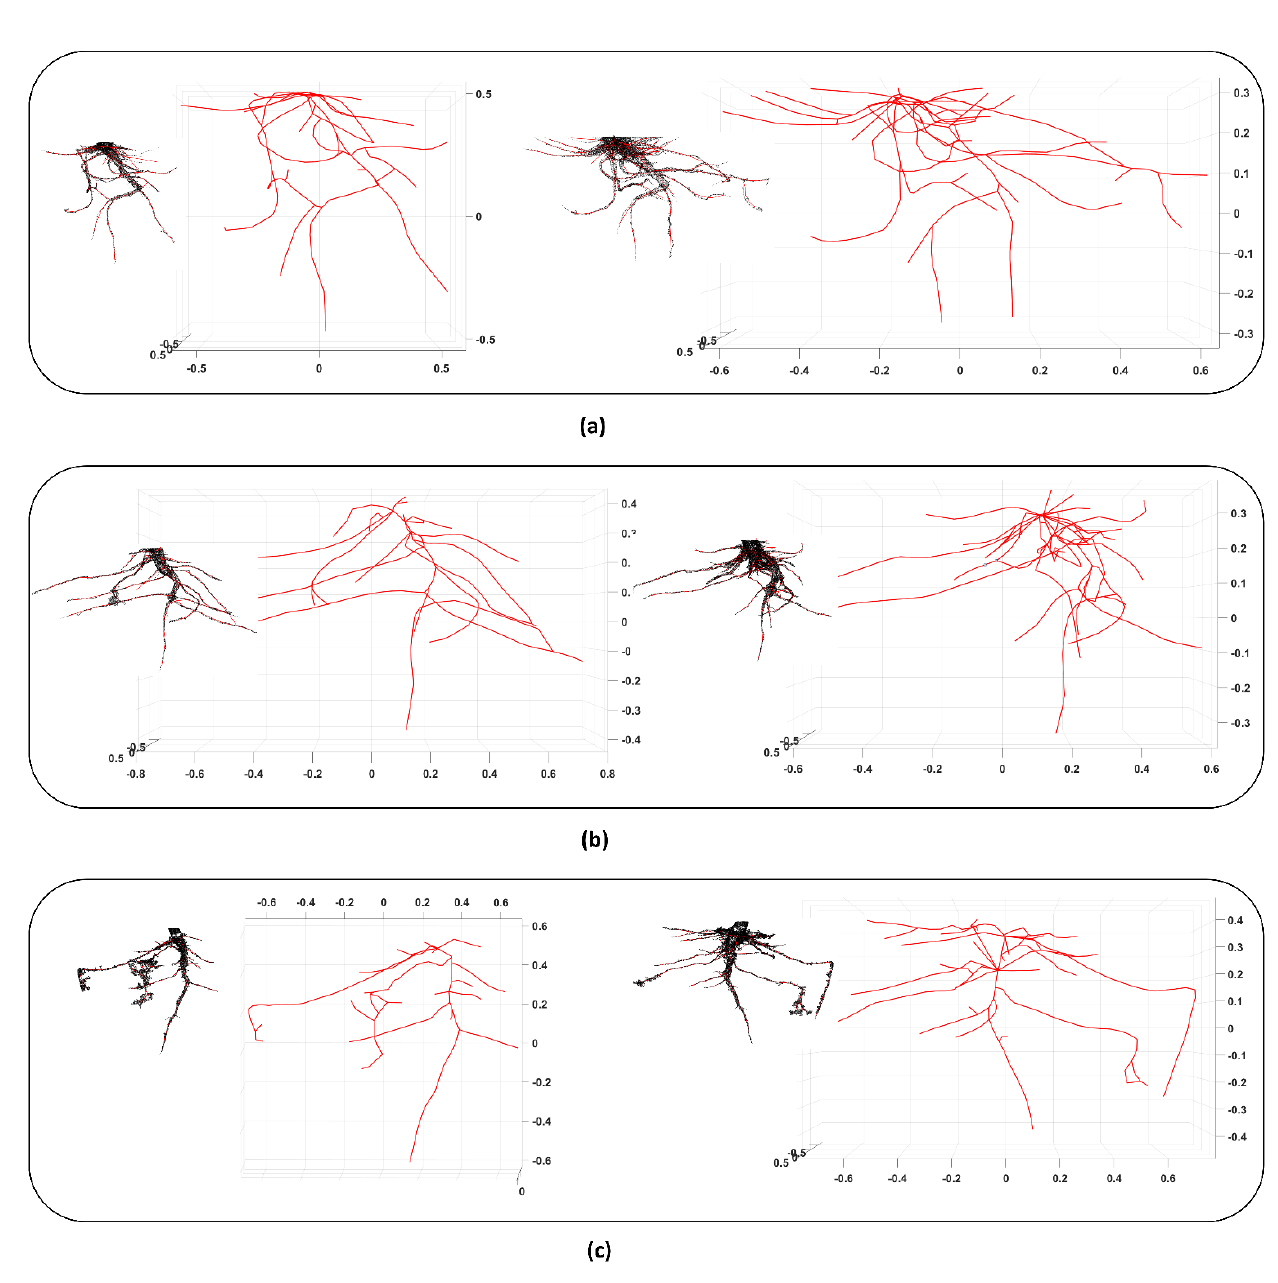
Figure 1. Skeleton of tomato root samples in relative units and a small figure representing the digital twin in black with the embedded skeleton in red: scan ID 111 and 112 (a), scan ID 121 and 122 (b) and scan ID 131 and 132